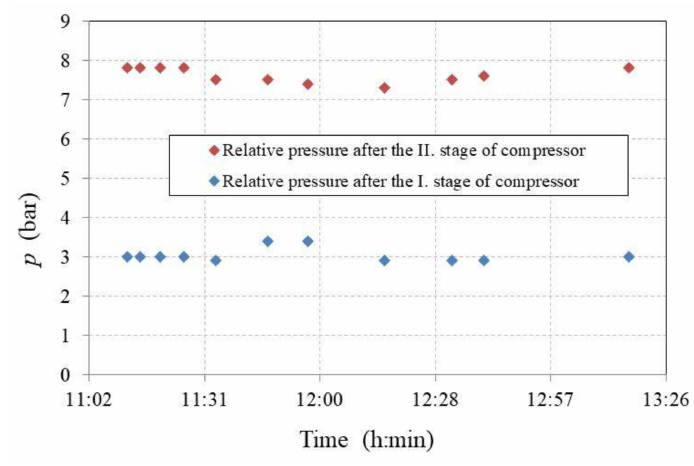
Figure 7. Relative gas pressure after the first and second stages.